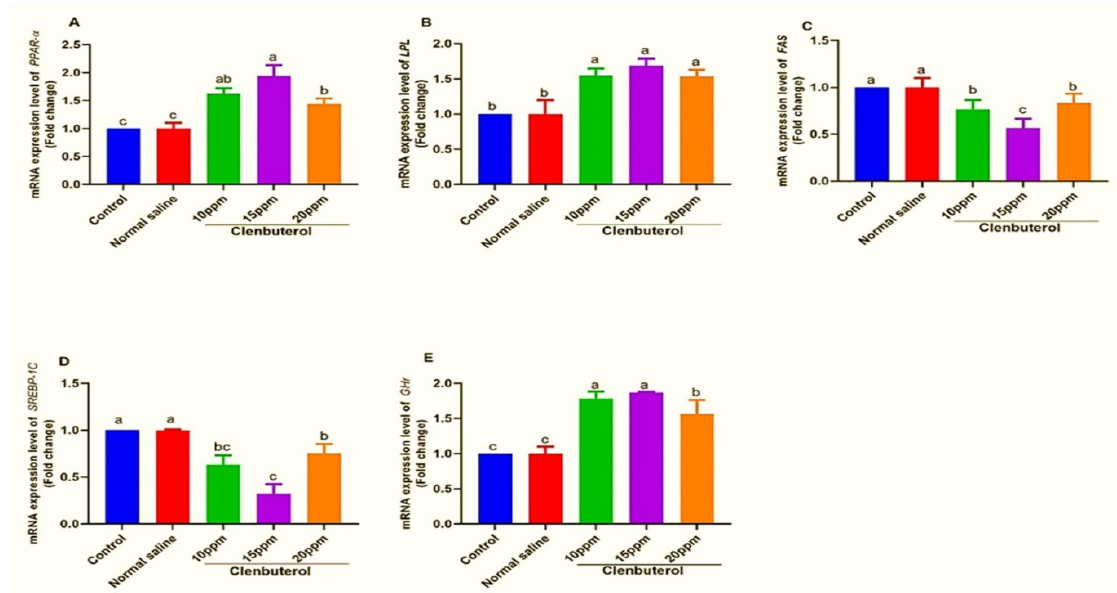
Figure 2. Expression of fold changes of hepatic ( A ) PPAR α , peroxisome proliferator-activated receptors, ( B ) LPL , Lipoprotein lipase, ( C ) FAS , Fatty acid synthase, ( D ) SREBP-1c , Sterol regulatory element-binding protein 1, ( E ) GHR , growth hormone receptor. Data Mean ± SE were analyzed with one-way ANOVA followed by Duncan’s multiple comparison test. Columns with differ superscripts (a, b, c, d) differ significantly ( p < 0.05)